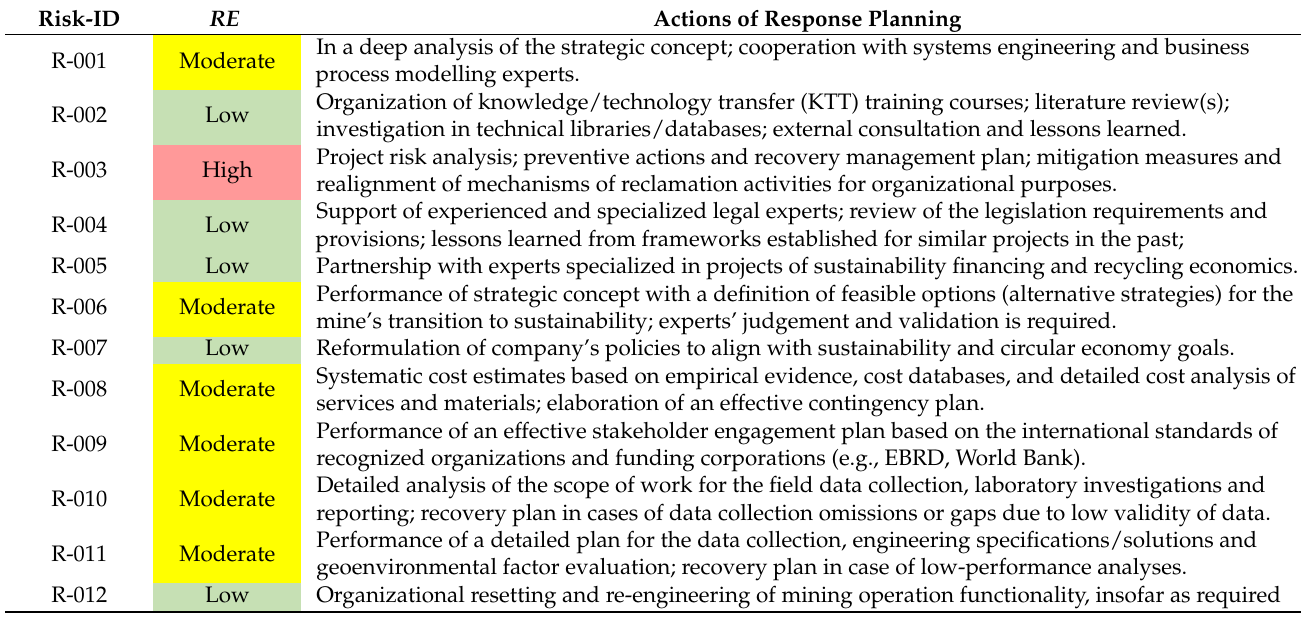
Table 12. Risk response